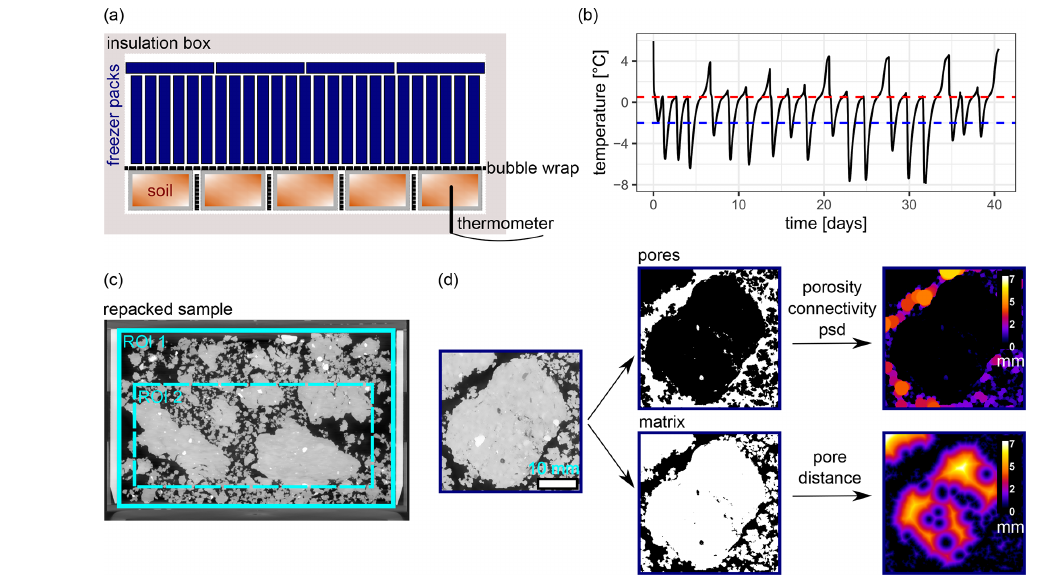
Figure 1. Experimental set-up of the study (a) , the temperature profile during the experiment (b) , vertical view of a repacked silt clay sample with two different regions of interests for image analysis (c) , and an overview of the different parameters determined via image analyses to detect structural transformation (d) . The shown examples for pore size distribution ( d , top right) and pore distance measurements ( d , bottom right) contain 3-dimensional